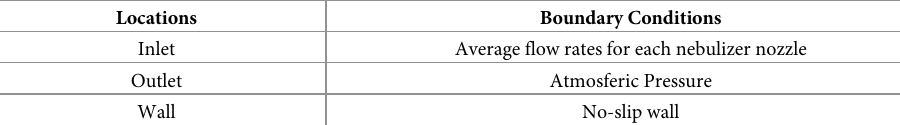
Table 1. Contour conditions of the disinfection chamber nebulizer nozzles.